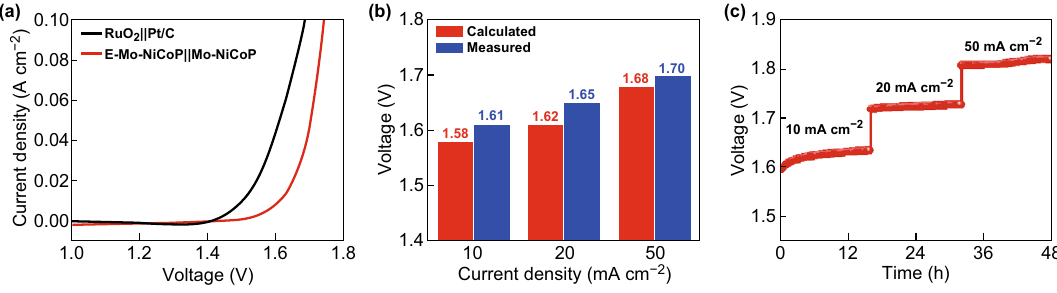
Fig. 5 a Polarization curves of obtained samples for overall water splitting. b The comparison of measured and calculated voltages for overall water splitting. c Long-term stability at constant current densities of 10, 20, and 50 mA cm